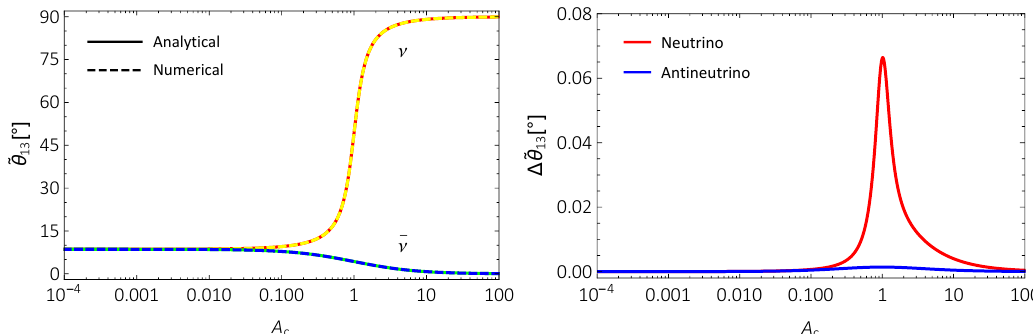
in the case of normal neutrino mass 13 (cid:17) e (cid:18) (analytical) (cid:0) e (cid:18) (numerical) 13 13 13